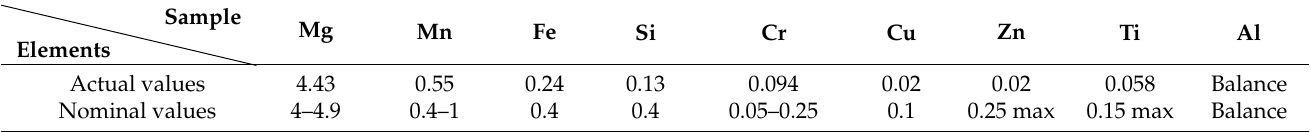
Table 1. Chemical composition of